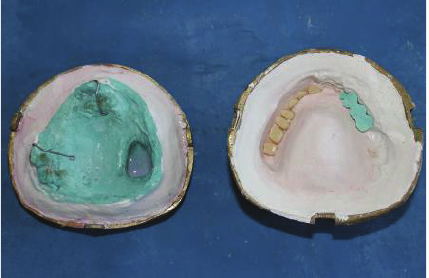
Figure 6: Bulb template of thermoplastic resin material.